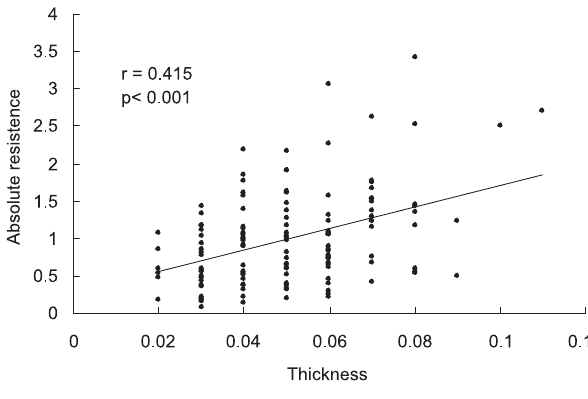
Figure 5 - Correlation between absolute resistance and